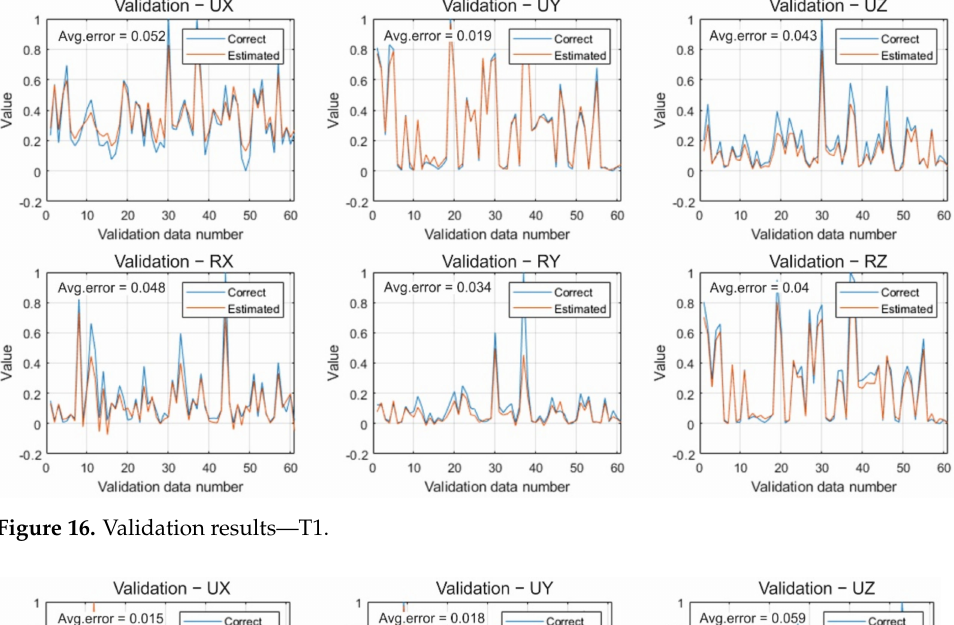
Figure 16. Validation results—T1.